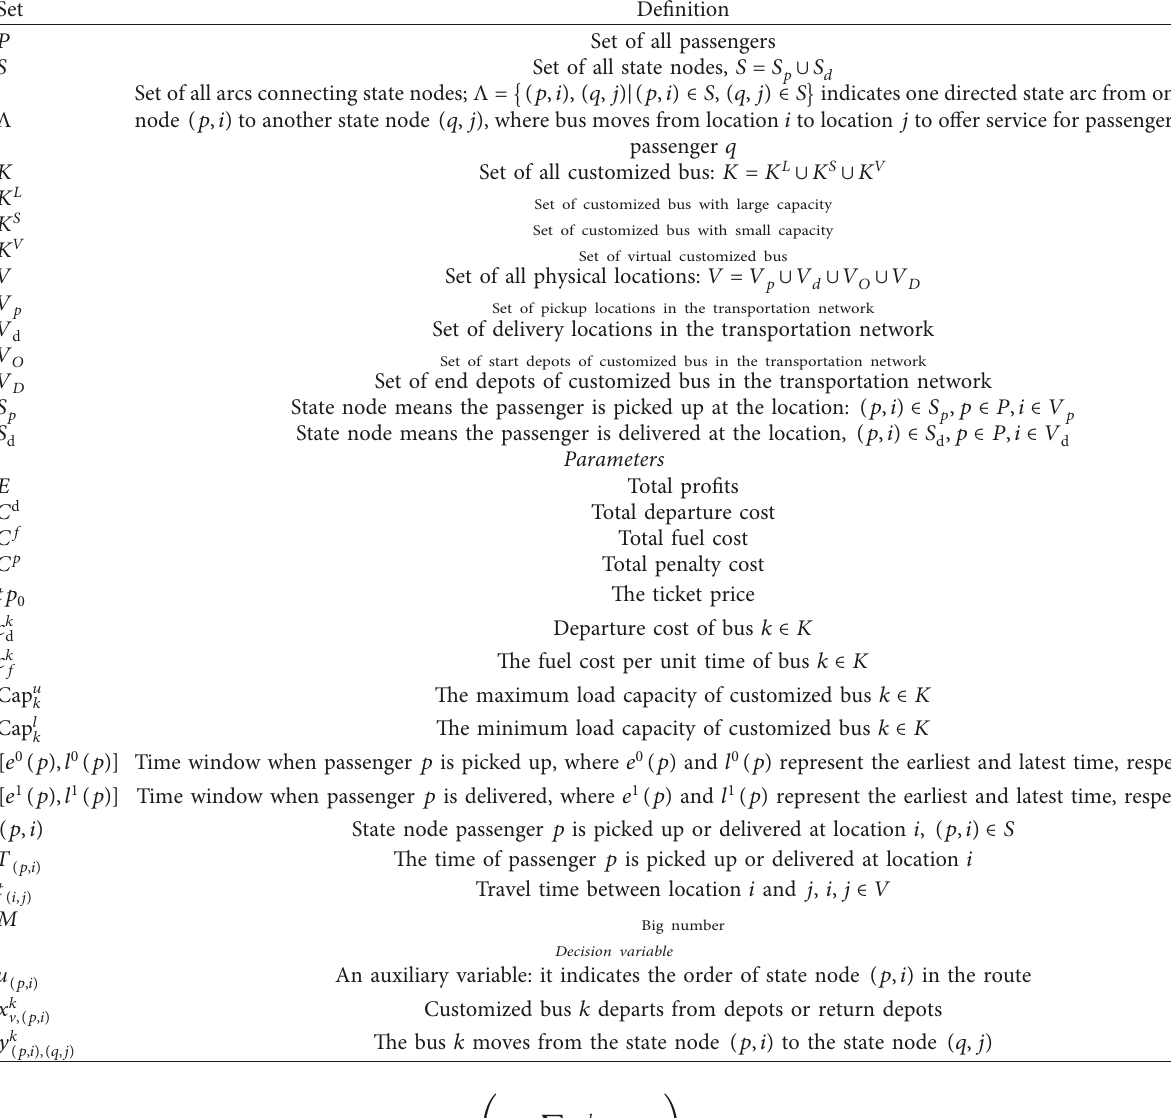
Table 1: Notation and definition in the